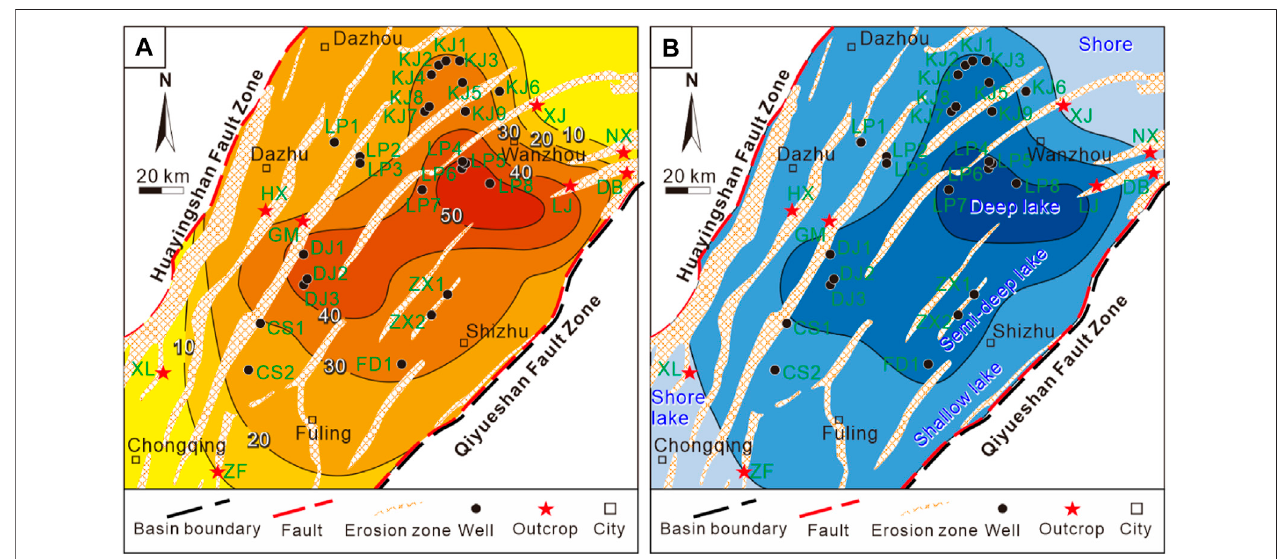
TABLE 1 | Mineral compositions of black shale in the Dongyuemiao member in the eastern Sichuan Basin. Well/outcrop Minerals (wt.%) Sedimentary